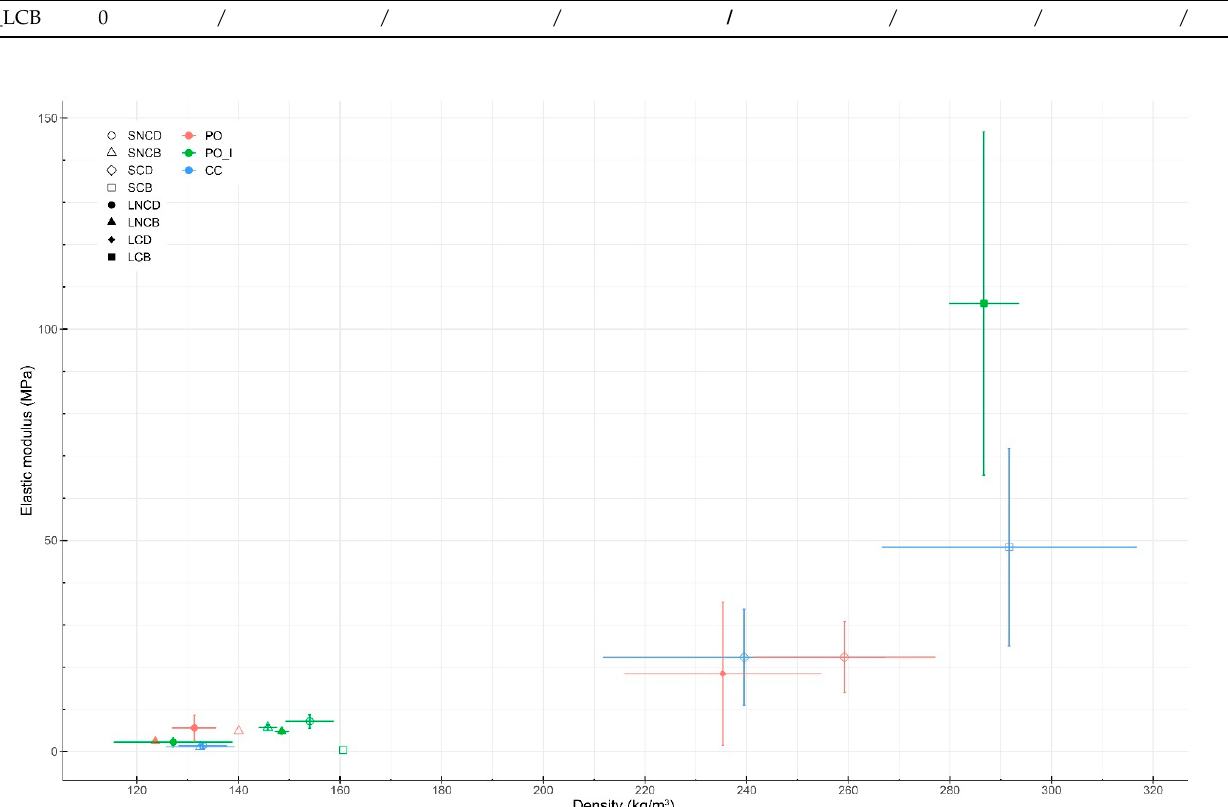
Figure 6. This figure shows the modulus of elasticity of samples in relation to their density prior to testing. “PO” stands for samples grown from Pleurotus ostreatus and the added “_I” means that corresponding samples were grown as extras under different growth environments, mold sizes, and timelines. “CC” refers to Coprinus comatus samples. Acronyms for each sample are labeled in Table